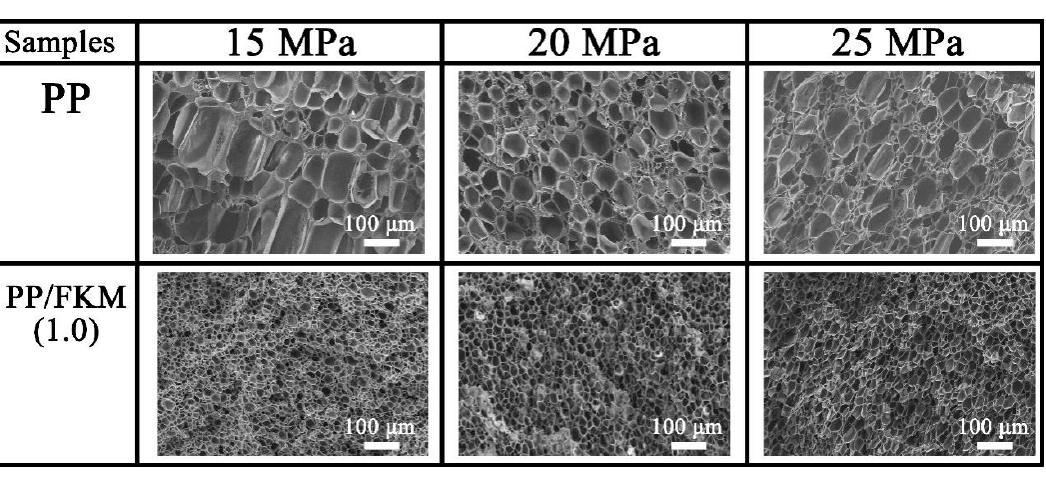
Figure 5. Mechanical properties of neat PP and PP/FKM foams: ( a ) tensile strength and ( b ) compressive strength.